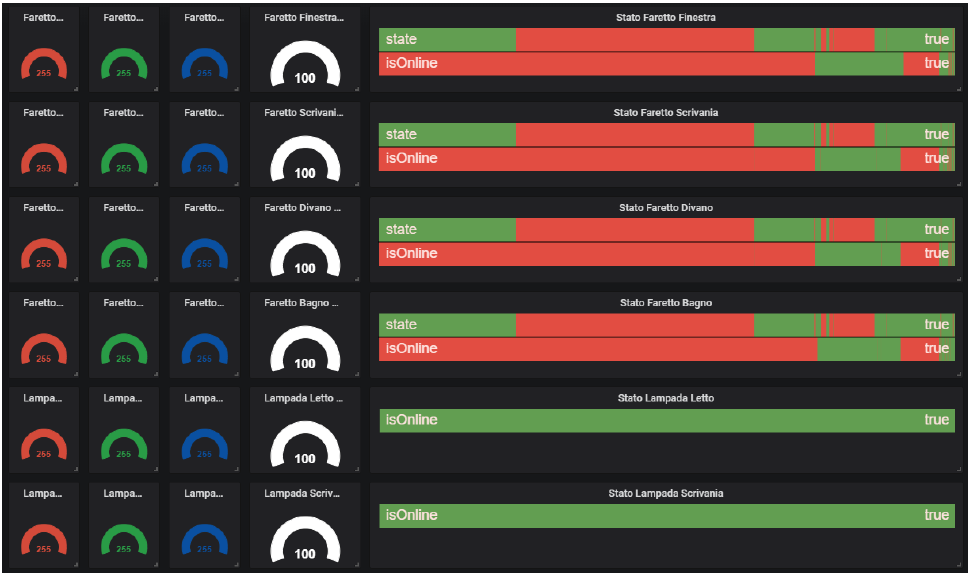
Figure 6. RGB light bulbs monitoring panel.